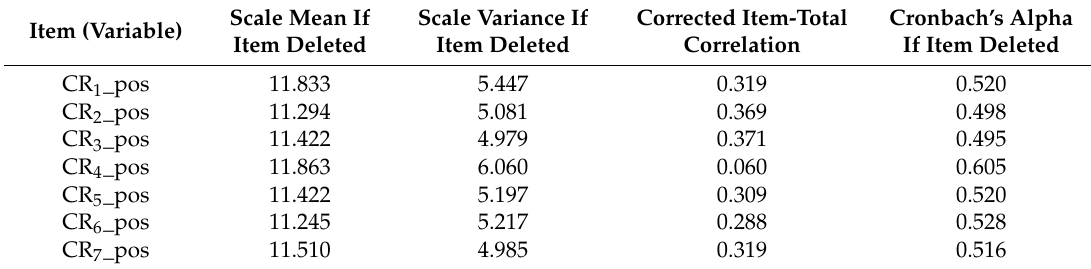
Table 2. Positive items overall statistics.